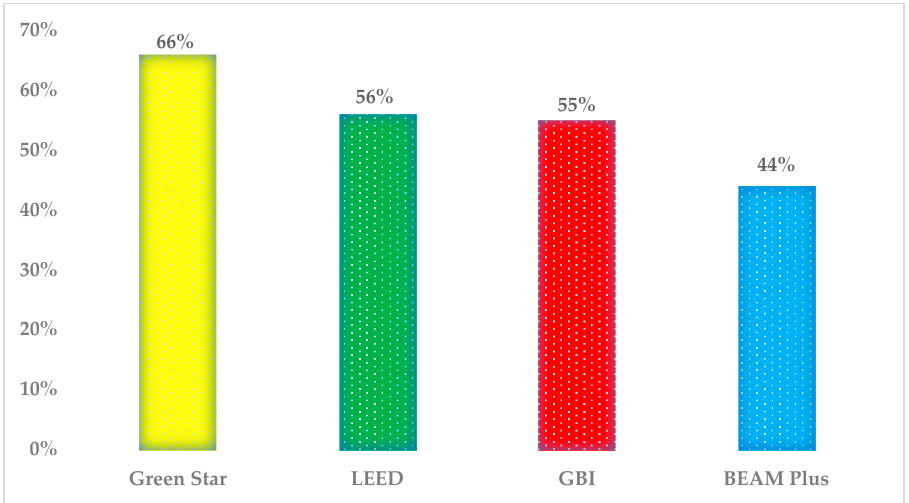
Figure 6. BIM assessment in the Green Building Tools.